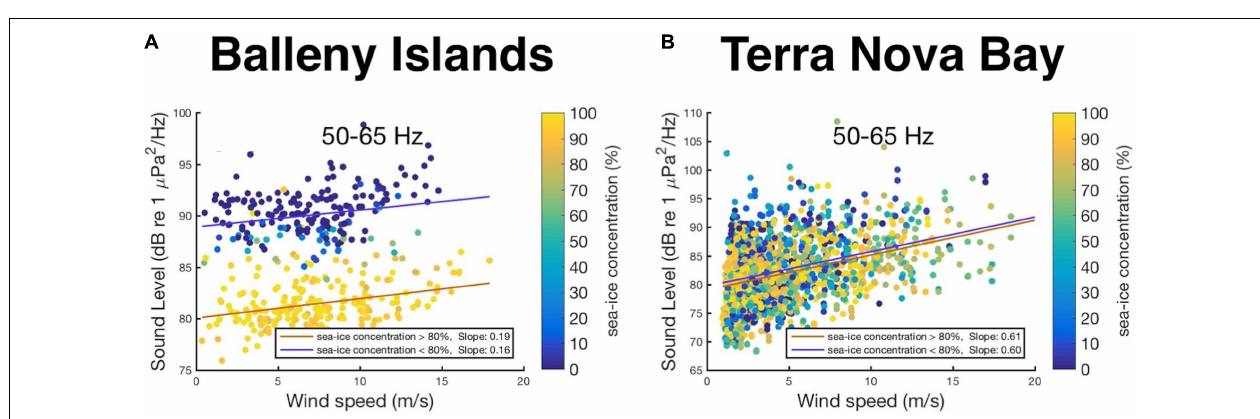
FIGURE 9 | Scatter plots of sound levels in the 50–65 Hz frequency range with respect to the wind speed with sea-ice concentration represented by color for (A) the BI region and (B) TNBP. The linear fittings to the data of sea-ice concentration greater than 80% and less than 80% are represented by orange and blue lines,